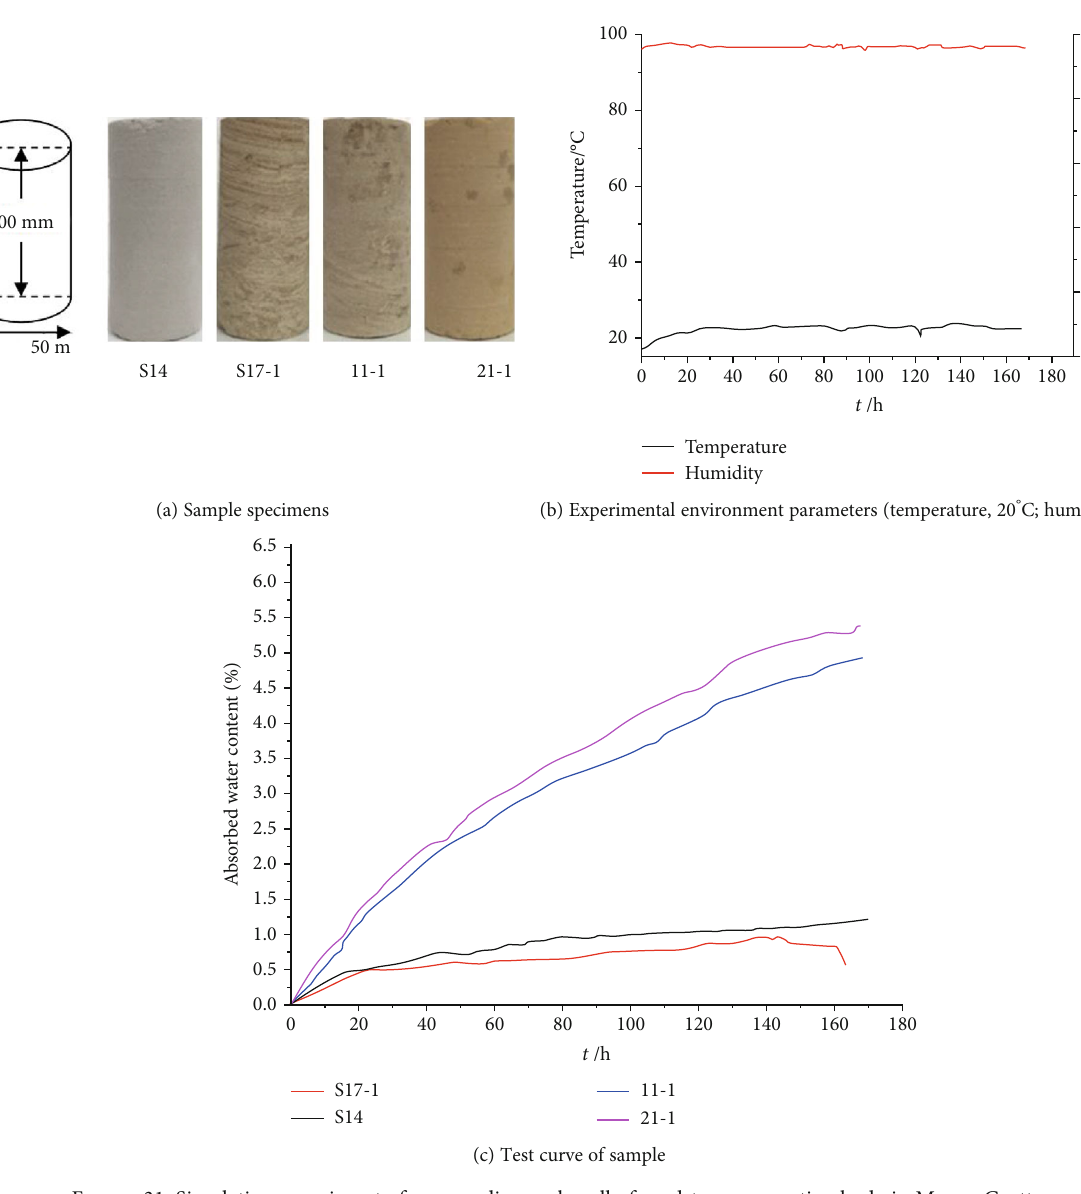
Figure 31: Simulation experiment of surrounding rock wall of mudstone supporting body in Mogao